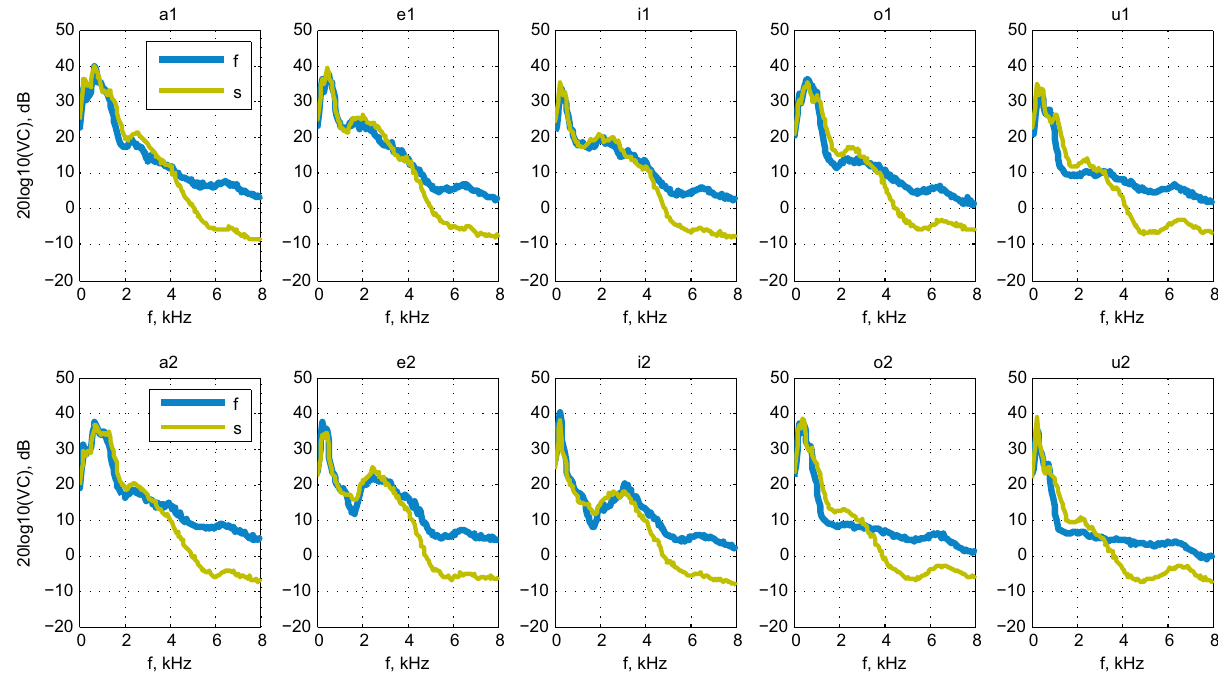
Figure 11. CVC logatomes: average vowel – consonant spectra ratio.